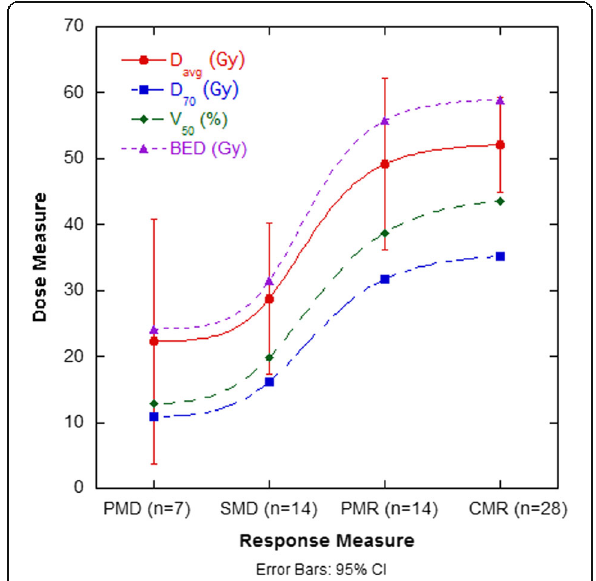
Fig. 2 Dose curves for each category of response for D avg , D 70 , V 50 and BED. Error bars represent the 95% CI for D avg